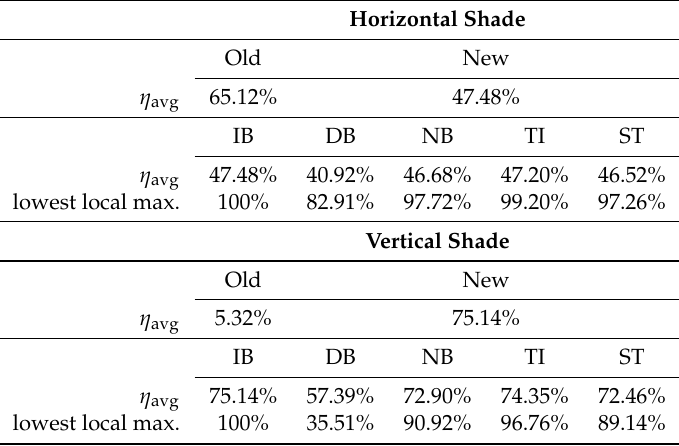
Table 2. Overview of the simulation results (IB: Ideal Bypass; DB: Diode Bypass, NB: NIMBUS; TI: SM74611 [20]; ST: SPV1520